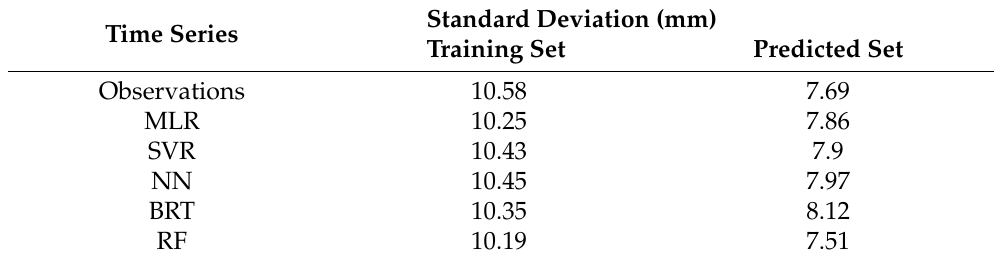
Table 6. Standard deviation of predictions and observations for the training and predicted